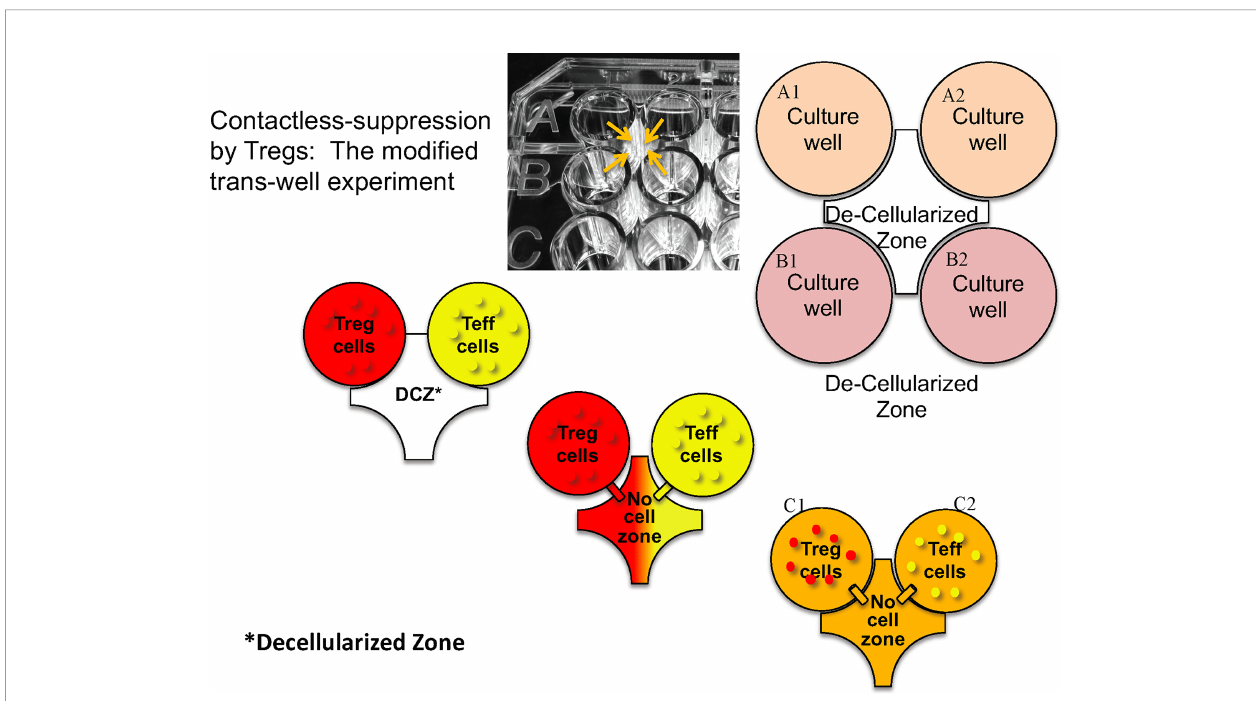
FIGURE 2 | Design of microtiter plate to test whether direct cell contact is necessary for the bystander effect. Tregs and T effectors (Teff) and placed in the same or contiguous wells with a hole created above the bottom of the wells (arrows) so that fl uid but no cells can migrate. “ Decellularized ” zone refers to the space between the four wells into which soluble products can diffuse to neighboring